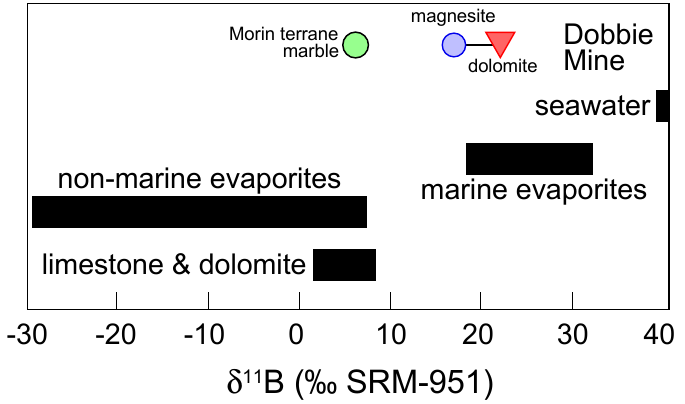
Figure 7. Boron isotope ratios of samples from the Dobbie mine and a comparison sample of Morin terrane marble. Representative boron isotope compositions from [24].